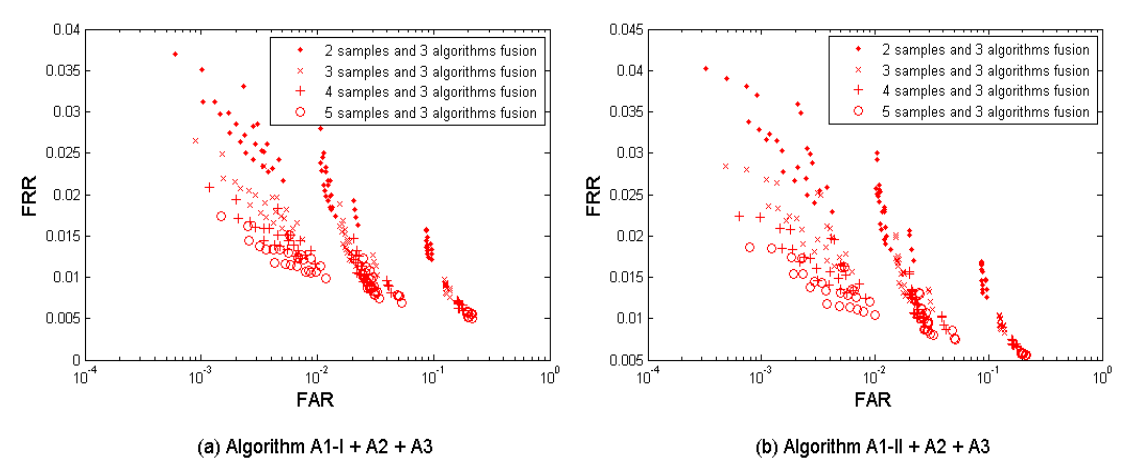
Figure 7. Multi-sample-algorithm fusion results from the tested three algorithms